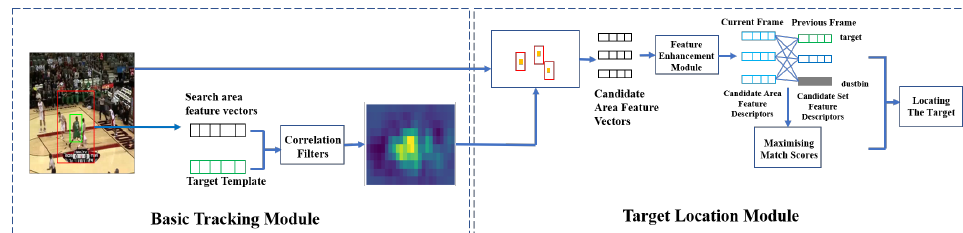
Figure 1. Algorithm framework